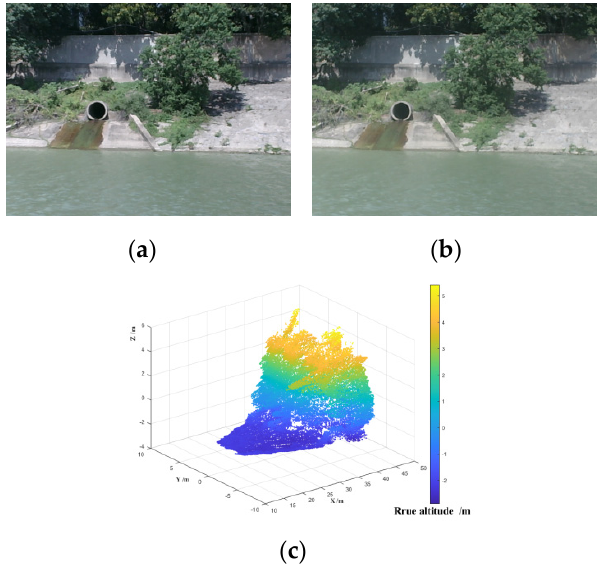
Figure 5. Three-dimensional reconstruction of binocular stereo vision: ( a ) left image; ( b ) right image; ( c ) 3D point clouds obtained.